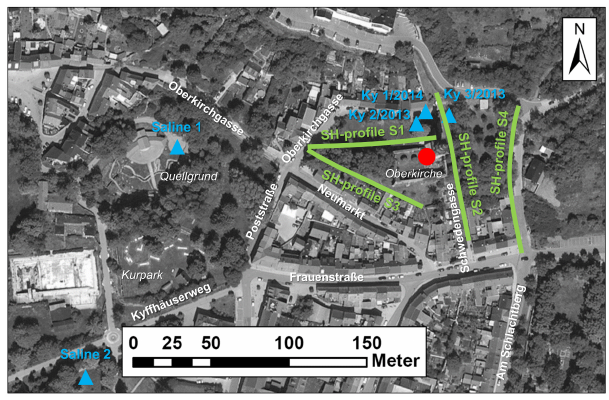
Figure 4. Seismic reflection profile locations in the survey area. The four SH-wave seismic reflection profiles (light green lines) were carried out around the leaning church tower of the “Oberkirche” (red dot) to investigate subrosion structures responsible for the con- stant sagging of the surface. Close to the “Oberkirche” five bore- holes exist for calibration (blue triangles; for a detailed description see Fig. 11). Saline 1 and Saline 2 are historical boreholes from 1857 and 1866, drilled to extract brine. Their stratigraphy is rather approximate. Ky 2/2013 and Ky 3/2013 are pre-investigation bore- holes for the deep research borehole Ky 1/2014. These wells are well documented, including, e.g., stratigraphy, density, susceptibil- ity, gamma ray logging, temperature, and conductivity (ArcGIS, Open Source Map). Figure 5. Field campaign in July 2014 under variable survey condi-